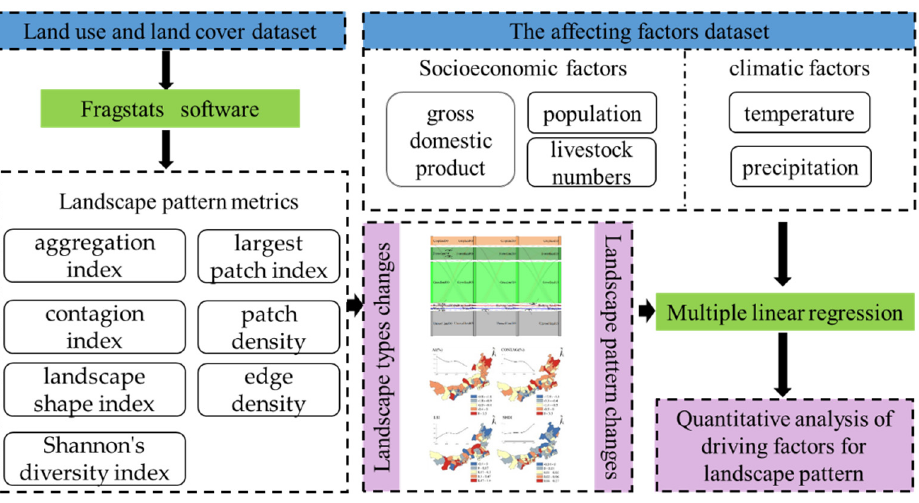
Figure 2. Methodological framework.